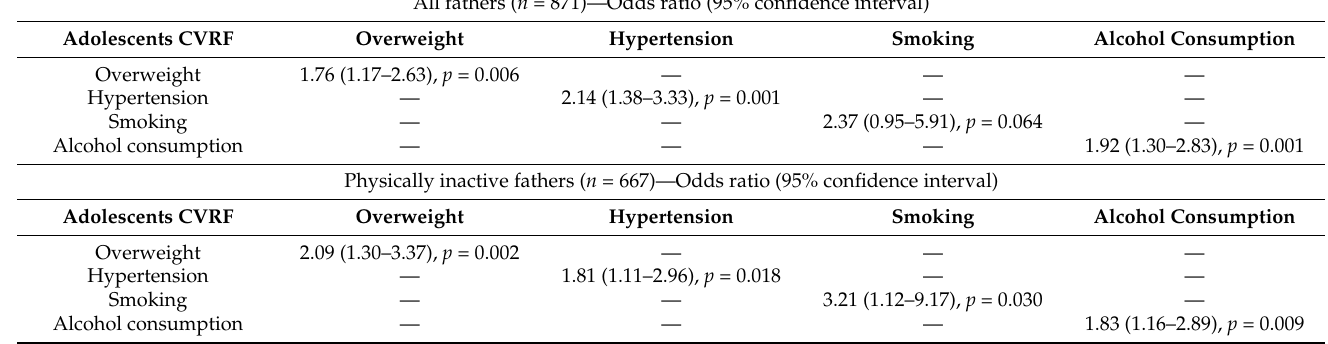
Table 3. Association between the presence of cardiovascular risk factors in fathers and in their children according to the physical activity level of